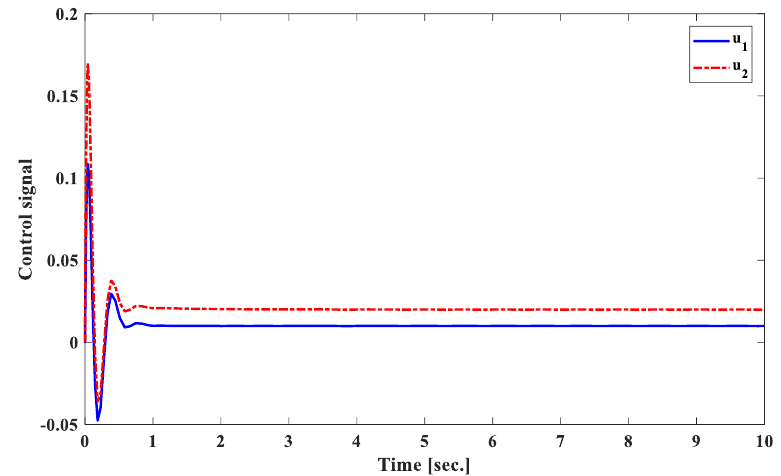
Figure 11. Control input [p.u.] of two control areas with matched disturbances.